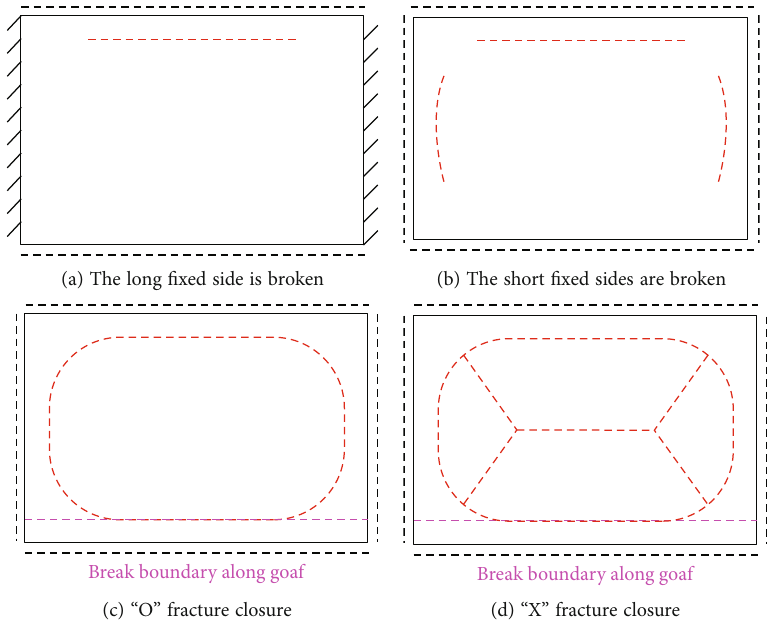
Figure 4: Evolution process of “ O-X ” fracture in small mining